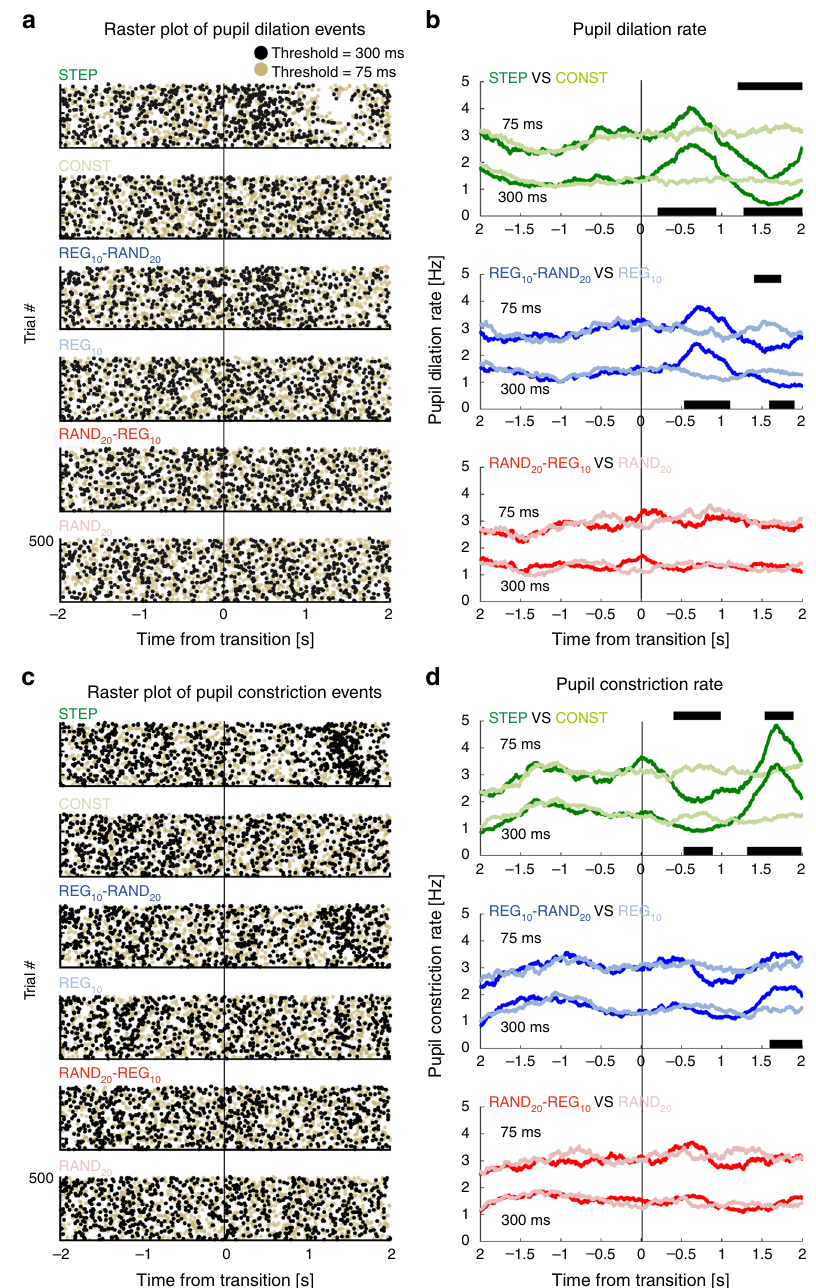
Fig. 3 Experiment 1: pupil dilation and constriction rates. a Raster plots of pupil dilation (PD) events extracted from all trials and all participants (collapsed over Experiment 1A & B). Each line represents a single trial. Black dots represent the onset of a pupil dilation with a duration of at least 300 ms, yellow dots represent pupil dilation onsets with a threshold duration of 75 ms. Transition time is indicated by a black vertical line. b Pupil dilation rate (running average with a 500-ms window) as a function of time relative to the transition. The black horizontal lines indicate time intervals where cluster-level statistics showed signi fi cant differences between each change condition and its no-change control. The statistics for the PD rates with a threshold duration of 75 ms and 300 ms are placed above and below the graph, respectively. c , d present the pupil constriction (PC) rate results, arranged in the same RAND 20 compared with CONST and REG 10 , with the latter two not differing signi fi cantly ( p = 0.083; Bonferroni corrected). To avoid confounds due to false positive disparities, all false positive trials were excluded from pupil analysis.